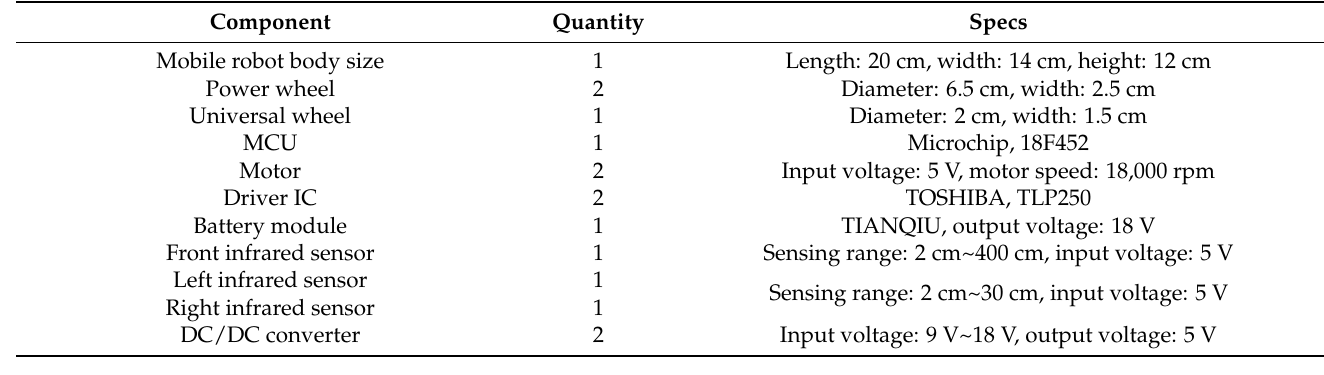
Table 2. Component specifications of the self-driving electric mobile robot.